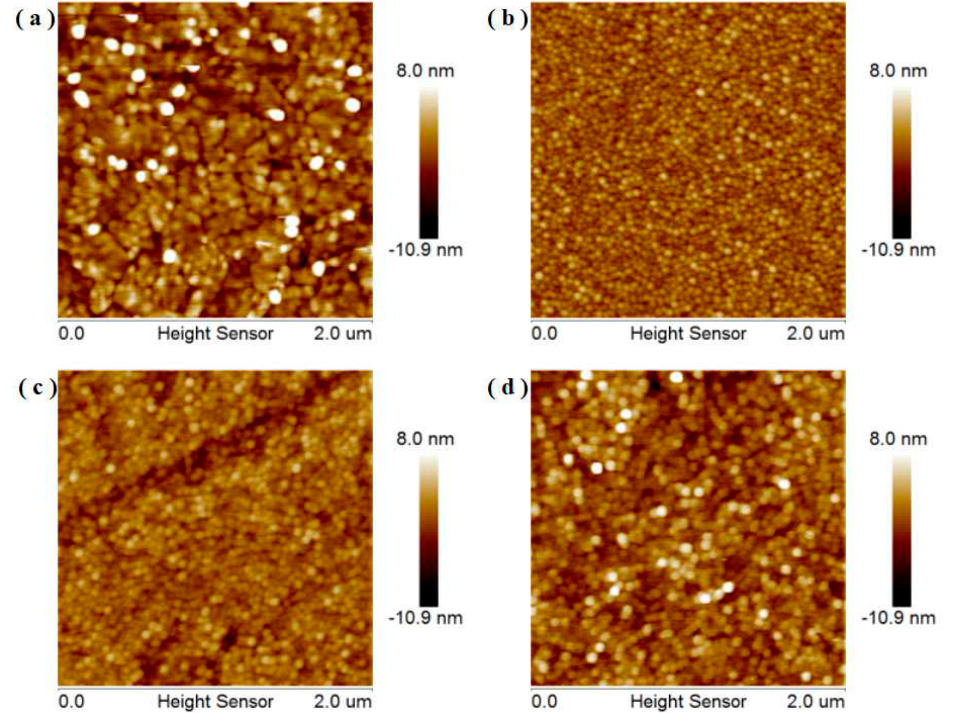
Figure 2. Atomic force microscopy (AFM) images of the Zr-based thin film metallic glass (VO 2 /Cu 50 Zr 50 /glass) thin films with different Cu 50 Zr 50 thicknesses. ( a ) No thin film; ( b ) 40 nm thickness; ( c ) 80 nm thickness; and ( d ) 160 nm thickness.